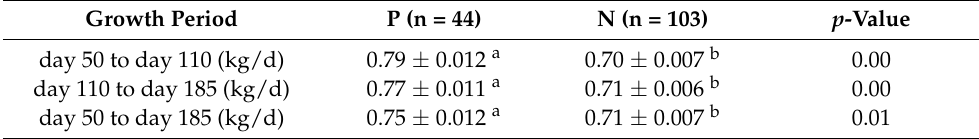
Table 5. The daily gain of antibody-positive and antibody-negative pigs at different period. Growth Period